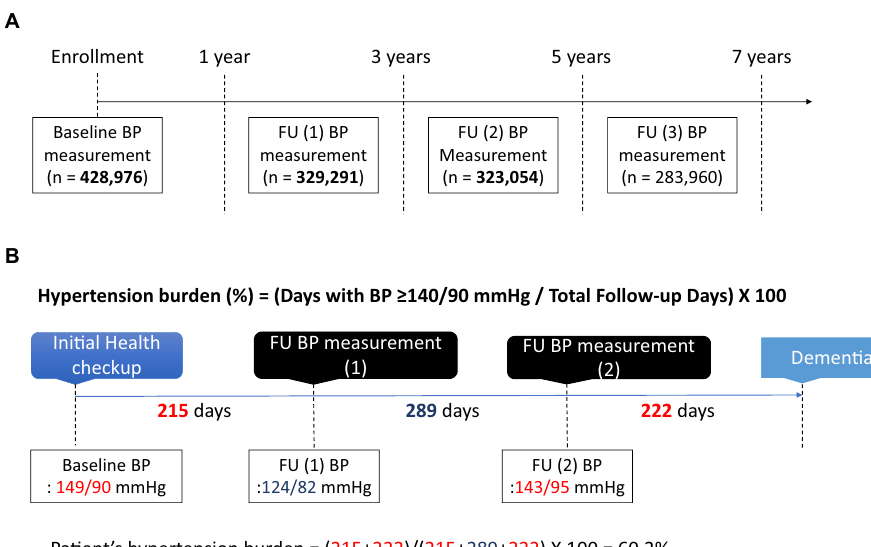
Figure 2. ( A ) Timeline of blood pressure measurements and ( B ) estimation of hypertension burden during follow-up. BP blood pressure, FU